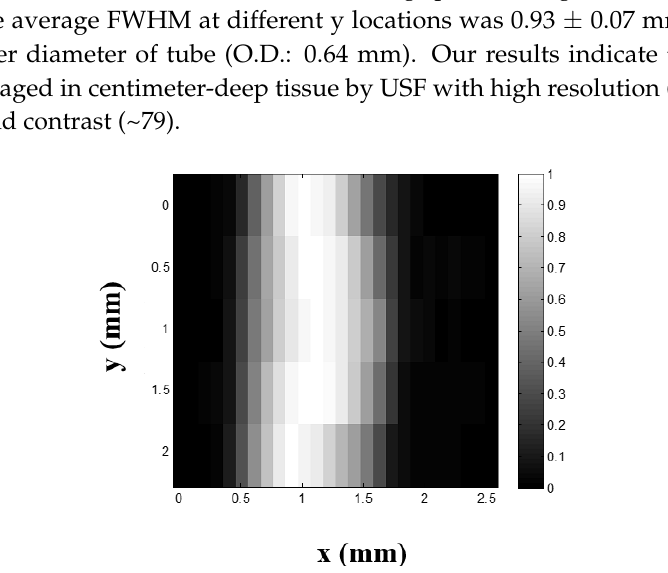
Figure 8. The ultrasound-switchable fluorescence (USF) image of the micro-tube embedded into the tissue-mimicking phantom; ADP(CA) 2 -encapsulated thermo-sensitive nanocapsules were used as the contrast agents.